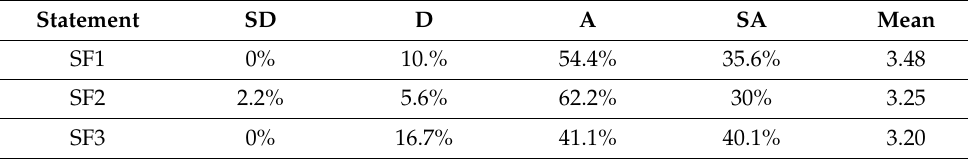
Table 9. Impact of COVID-19 pandemic on student’s feelings.